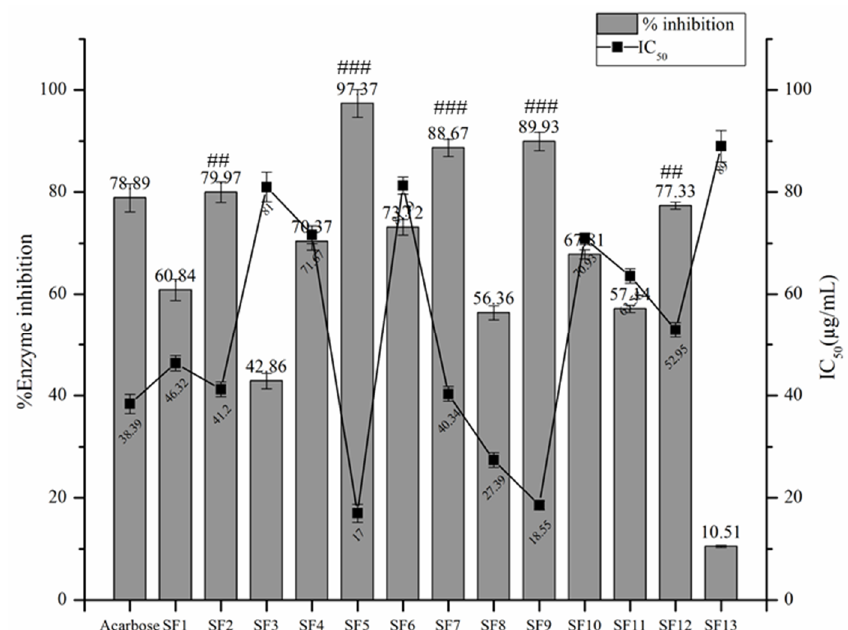
Figure 5. % inhibition of α -amylase enzyme by a library of synthetic compounds and a reference amylase inhibitor, acarbose (values are expressed as ± SEM, n = 3), ### indicates the significance of results where p < 0.01, ## p < 0.05.